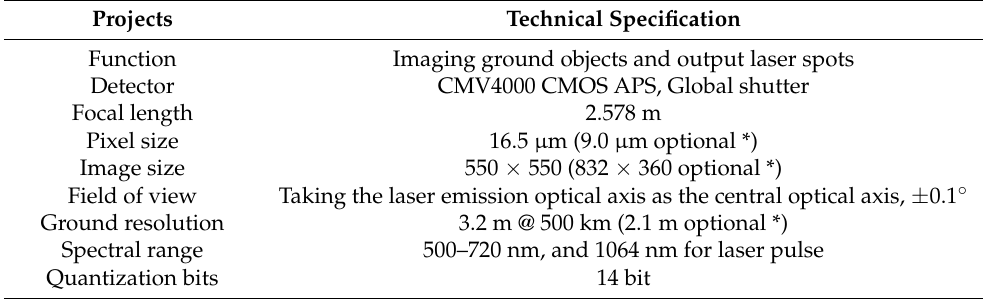
Table 1. Technical specification for the laser footprint cameras of GF-7